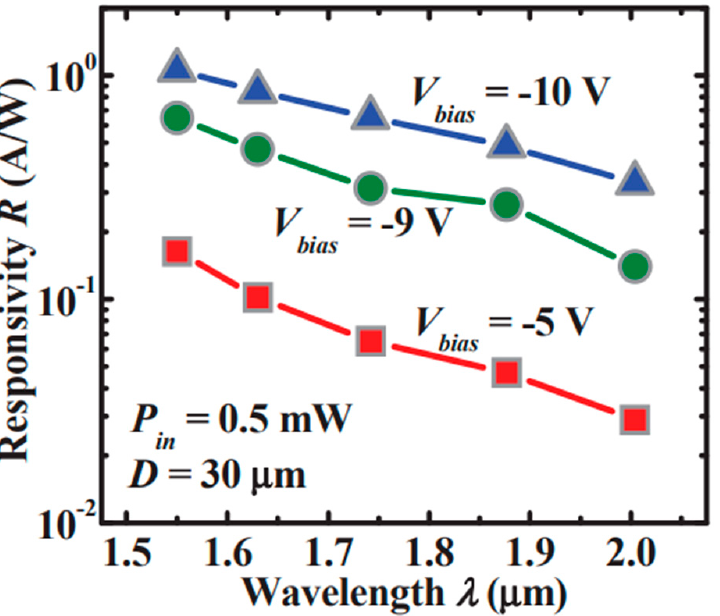
Figure 18. Optical responsivity for GeSn/Ge MQWs APD is biased at different voltages. Reproduced with permission from [75], IEEE, 2015.